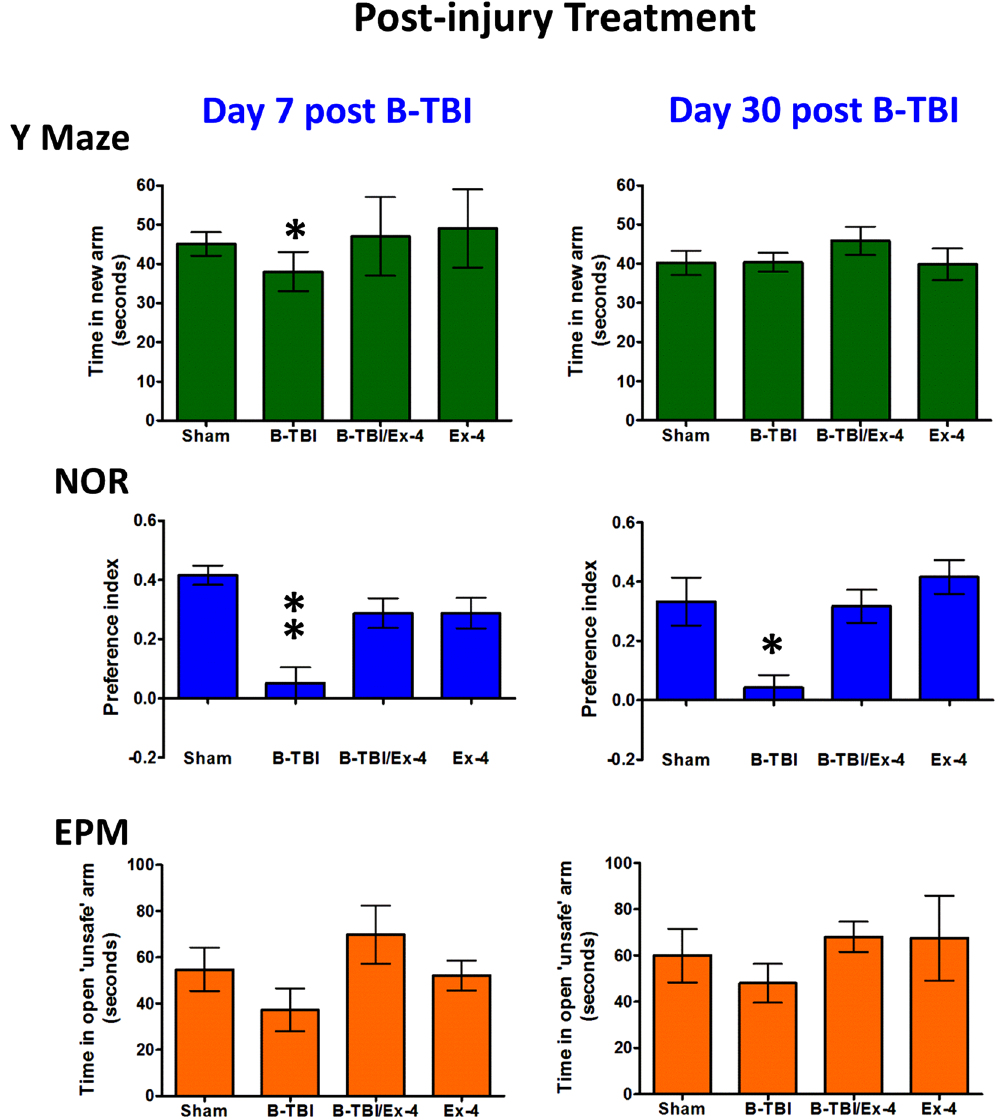
Figure 4. Effects of B-TBI on mouse cognition were attenuated by post-injury treatment with Ex-4. Upper Panel: B-TBI induced a significant deficit in spatial working memory of mice at 7 days post-B-TBI ( * p < 0.05); treatment with Ex-4 prevented the B-TBI-induced change in the Y Maze. Middle Panel: B-TBI animals exhibited significant impairments in object recognition memory at day 7 and 30 after B-TBI ( * , ** p < 0.05, p < 0.01). The impairments in NOR were prevented by Ex-4 at both time points. Lower Panel: Animals performed equally in EPM assessment. Data are presented as a mean ± s.e.m. of measurements. The numbers of animals per treatment group are provided in the methods